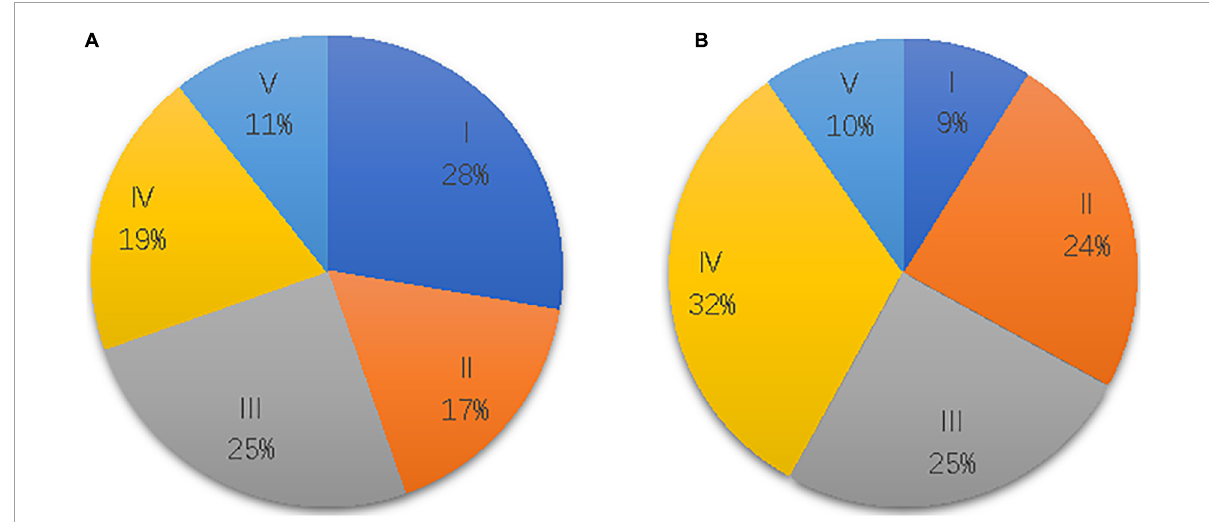
FIGURE1 Brunnstrom stage distributions in the hand (A) and upper limb (B) of 112